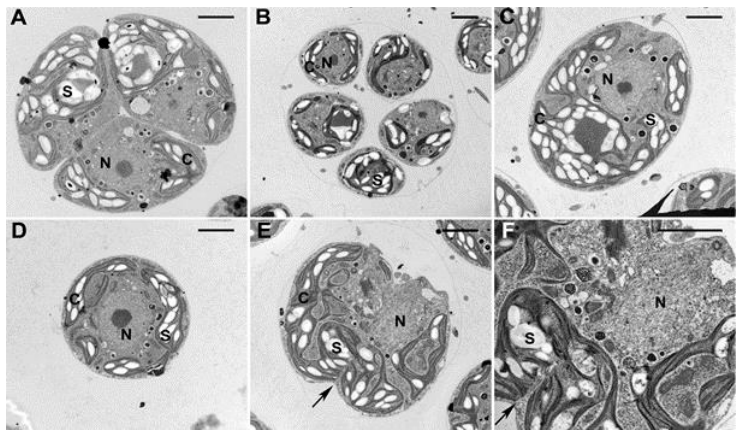
Figure 6. Electron microphotographs of cell divisions in untreated ( A ), caffeine-treated ( B ), zeocin- treated ( C ) and caffeine/zeocin-treated ( D – F ; F is an enlargement of E) C. reinhardtii cells. Bar = 2 µm. The untreated and caffeine-treated cells divided their nuclei (N) and chloroplasts (C) with large amounts of starch (S), zeocin and caffeine/zeocin-treated cells stay uninuclear (N), about 40% of the caffeine/zeocin-treated cells divided their chloroplasts and attempted to proceed with cell division (E, F arrow).